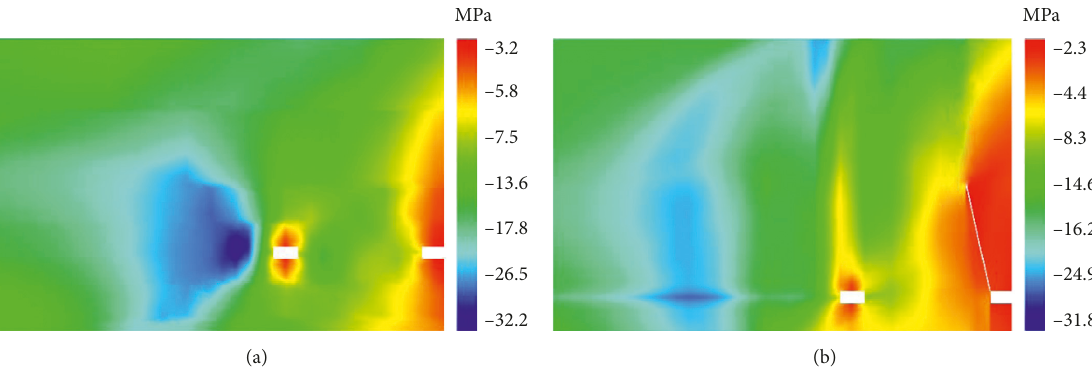
Figure 11: Vertical stress distribution of the roof strata of the 72908 haulage roadway (a) without presplitting blasting and (b) with presplitting